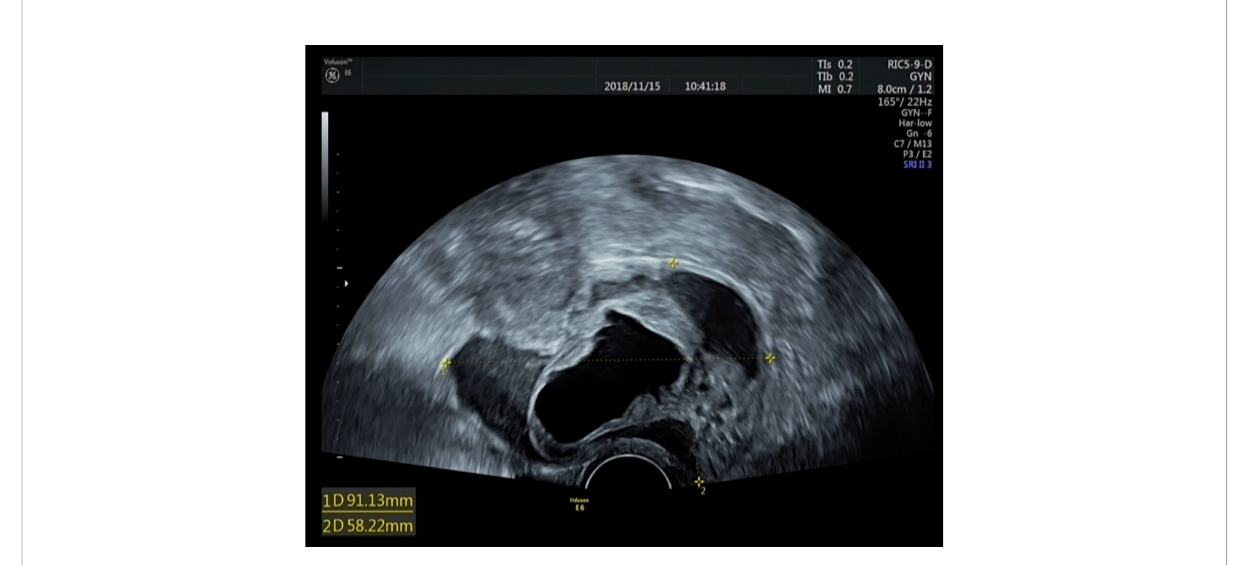
FIGURE 1 Ultrasound results of the tumor. Müllerian adenosarcoma of the uterine cervix is a cystic-solid mass measuring 9.1 × 8.1 × 5.8